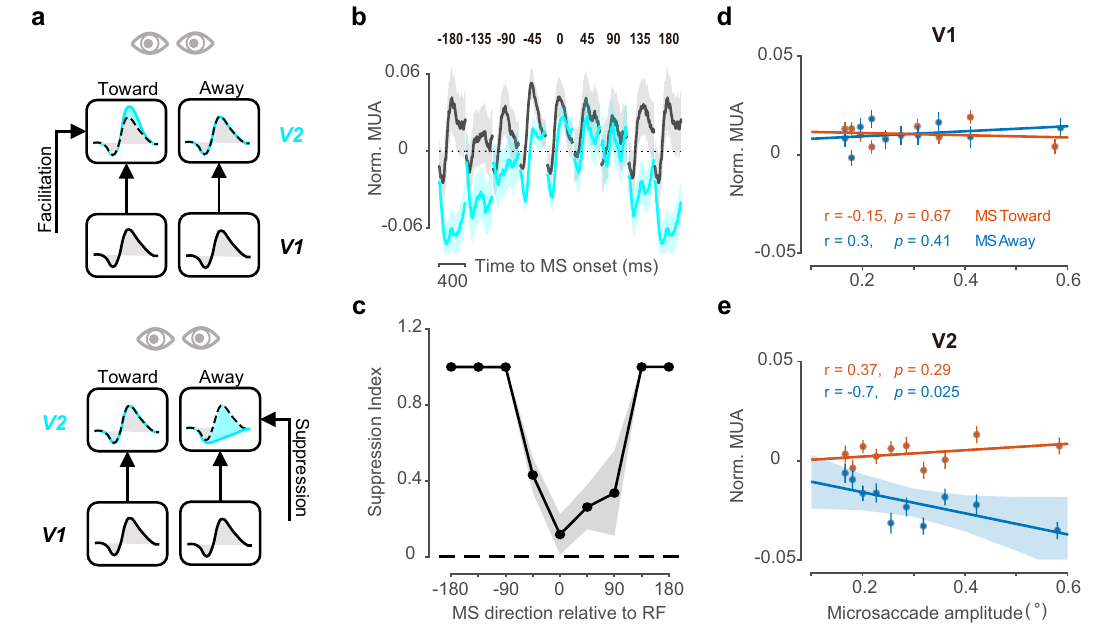
Fig. 3 | The suppression contributes to direction-speci fi c microsaccade mod- ulationinV2.a Schematicillustrationoftwomodulationforms.Top,inadditionto the feedforward drive from V1, an additional facilitation targets V2 neurons when microsaccades move toward theirRFs. Bottom, suppressive modulationtargetsV2 neurons when microsaccades move away from their RFs. b Normalized MUA (mean±s.e.) in V1 (gray) and in V2 (cyan) after microsaccades with 9 directions relative to RF locations of the recorded sites. c The relative direction tuning (MUA mean±s.e.) of the suppression index on the microsaccade. d V1 MUA (averaged